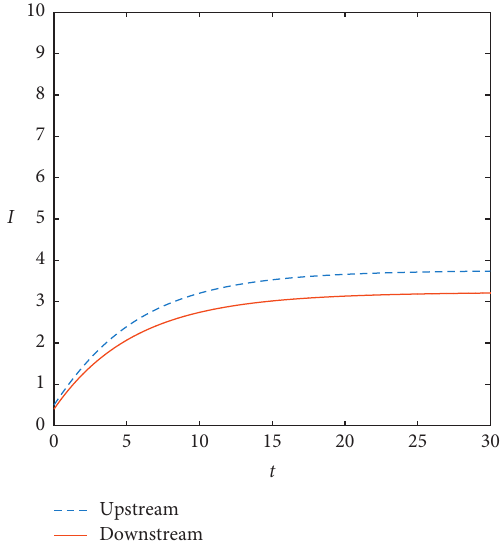
Figure 11: Optimal trajectory of pollution abatement investment under cooperation when the planning period T ⟶ ∞